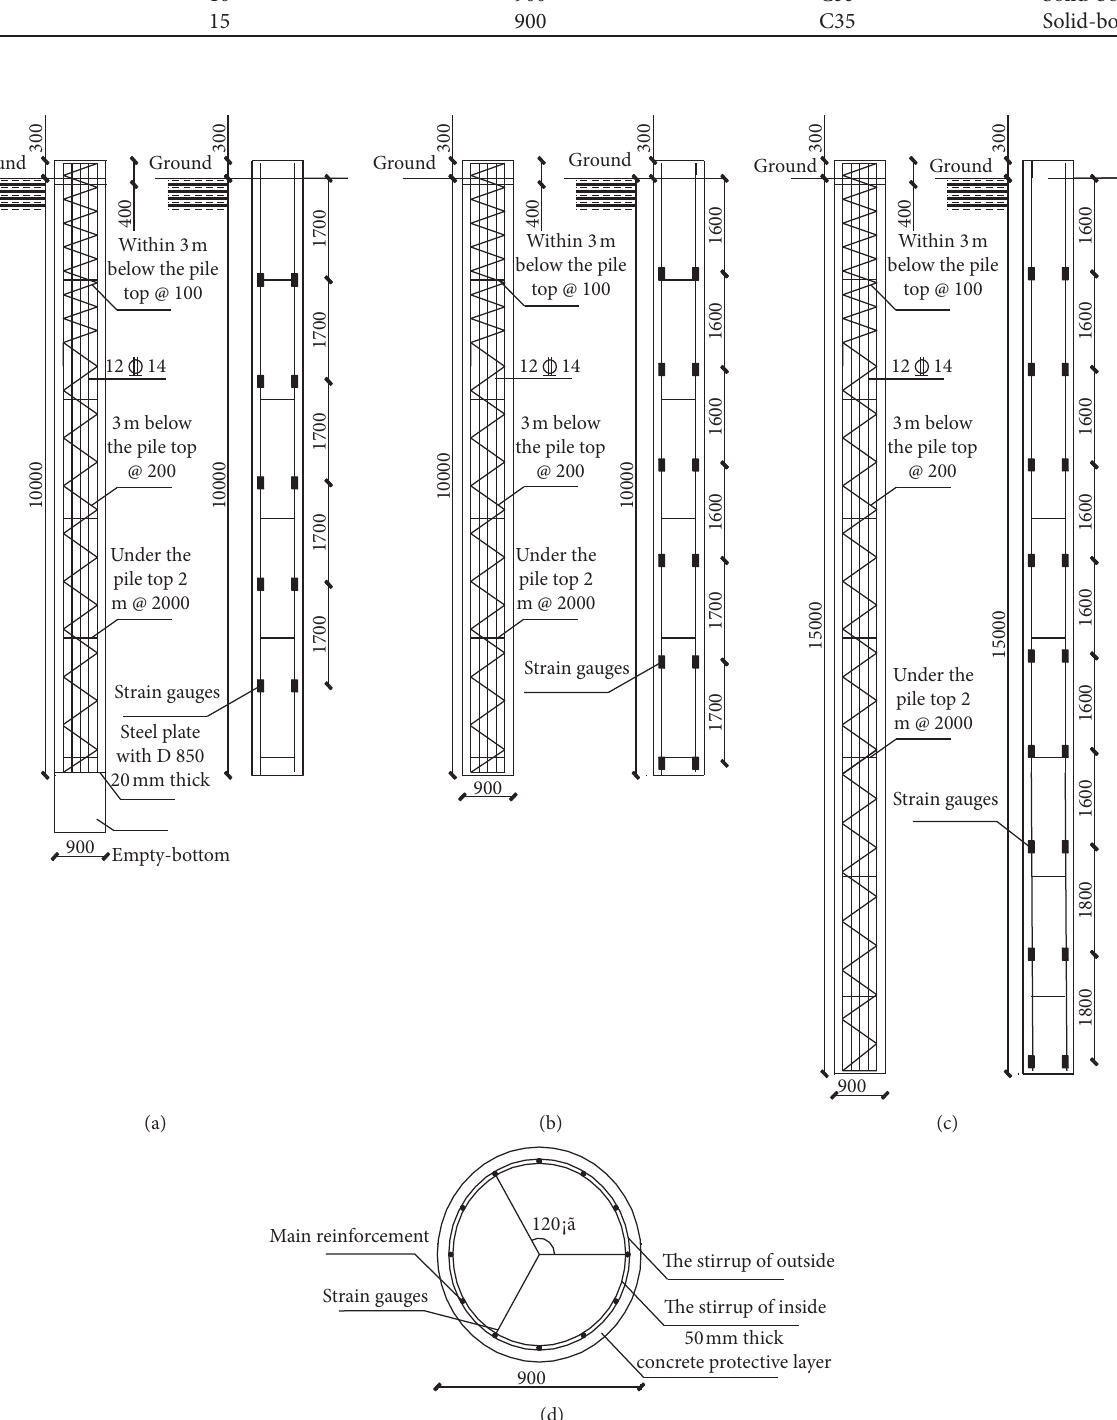
Figure 5: The reinforcement layout and strain gauges layout of the test pile. (a) Empty-bottom pile No. 1. (b) Solid-bottom pile No. 2 and No. 3. (c) Solid-bottom pile No. 4. (d) Plan of layout of